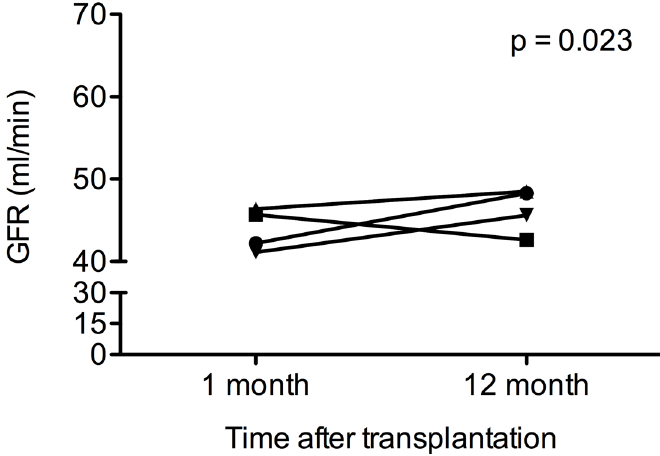
Fig 3. Incidence of rejection. The number of patient experiencing 1 or more biopsy proven rejections (including borderline cases with impaired renal graft function) according to the Banff 97 classification: 2 = antibody mediated rejection (AMR), 3 = borderline lesion, 4 I and 4 II = acute cellular rejection.